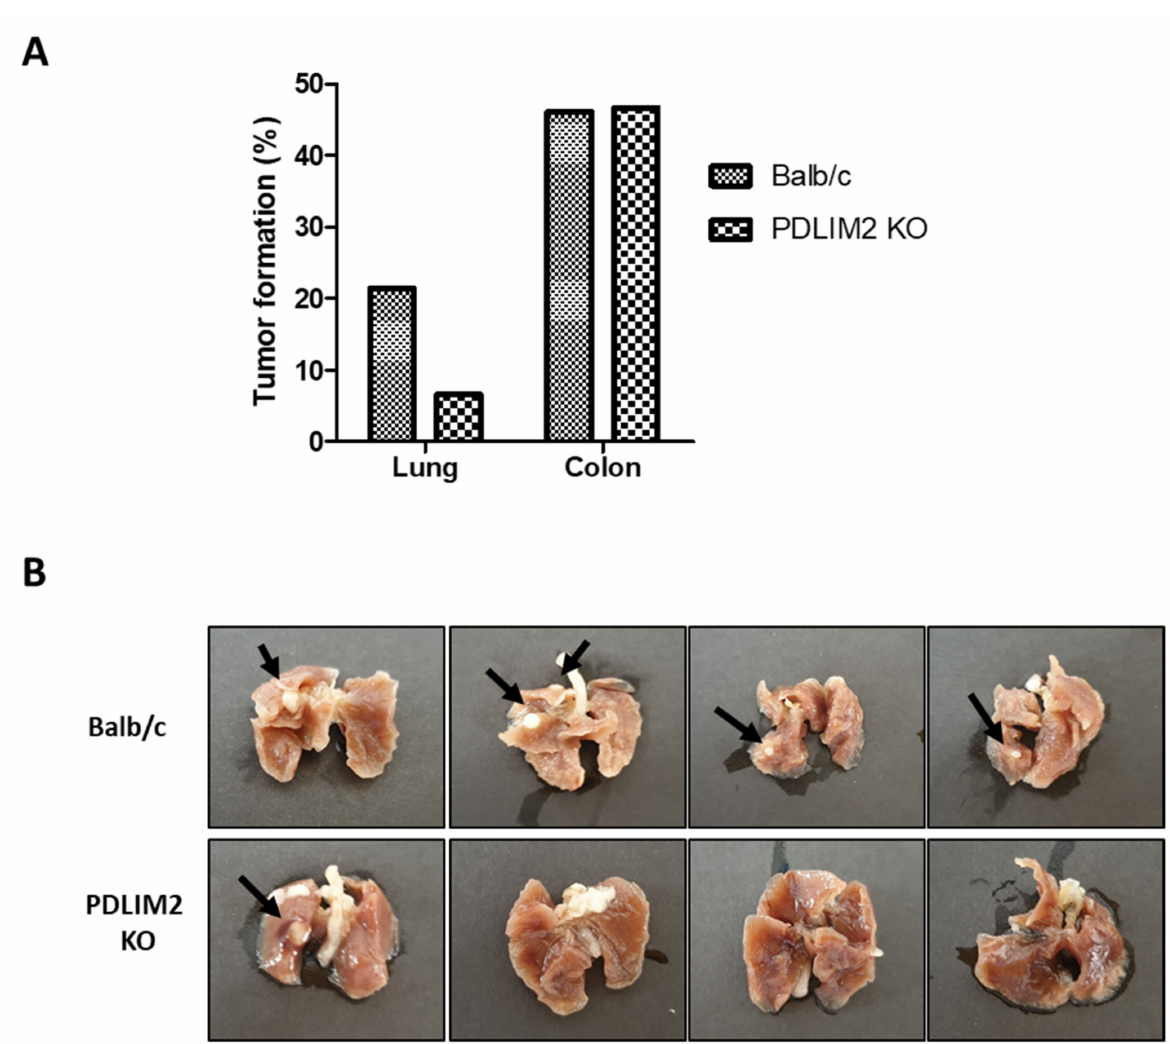
Figure 8. Lung cancer formation upon aging was reduced in PDLIM2 knockout mice. ( A ) Tumor formation rate in the lung and colon of 15-month-old wild-type (Balb/c) and PDLIM2 knockout (KO) mice: Balb/c ( n = 13), PDLIM2 KO ( n = 15). ( B ) Images of formaldehyde-fixed lungs extracted from indicated mice. Black arrows indicate lung